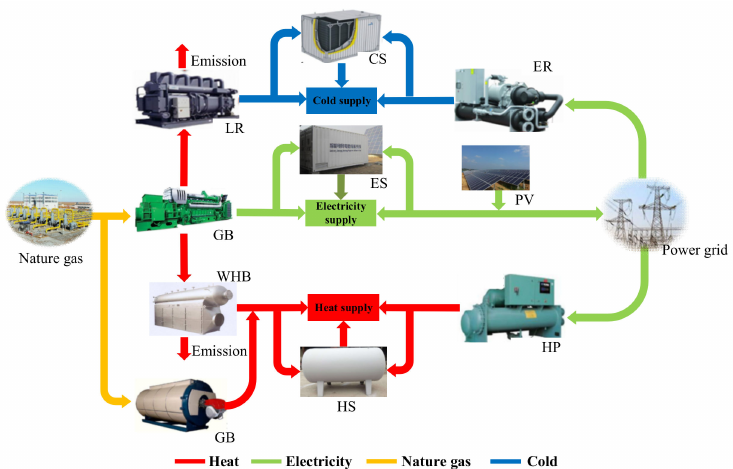
Figure 2. Topological structure diagram of internal equipment in energy station